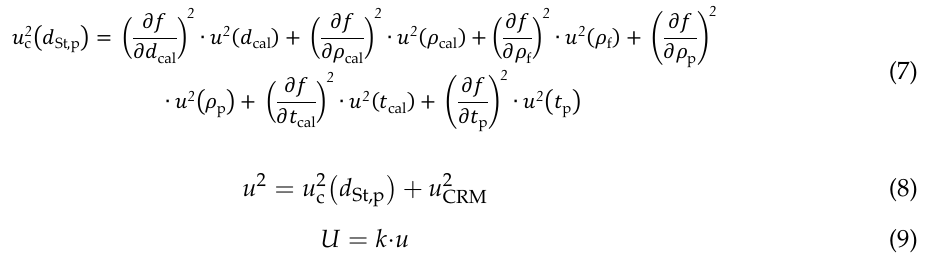
Table 5. Uncertainty budget for a single disc-CLS measurement (reference method) of nominally 20 nm silica nanoparticles